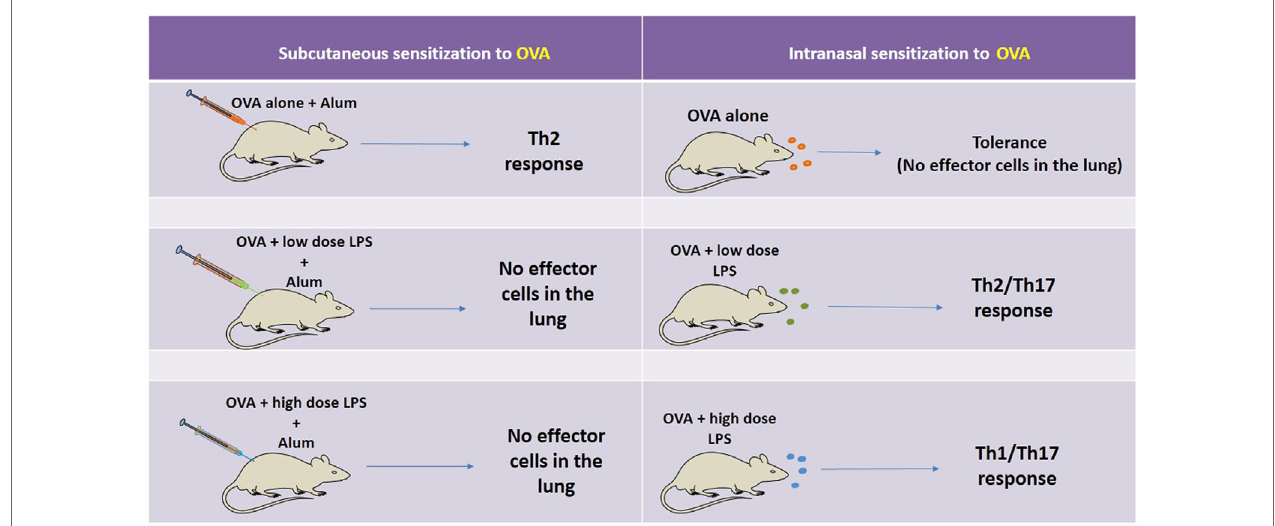
FiGuRe 2 | Schematic representation of the factors affecting OVA-model of allergic lung disease. On the left side, it is shown, that when sensitization is performed by the subcutaneous route with OVA adsorbed to Alum and the animals are challenged with intranasal OVA, an eosinophilic airway inflammation mediated by Th2 cells is developed. However, when the same sensitization is induced in the presence of low or high dose of lipopolysaccharide (LPS) and the animals are challenged with OVA, the airway inflammation is not developed. A different scenario is seen with intranasal sensitization to OVA. In this situation, OVA administration results in airway tolerance (no inflammation) while intranasal sensitization with OVA plus low or high dose of LPS results, respectively, in Th2-mediated airway eosinophilia or Th1/Th17-mediated airway neutrophilia. Therefore, part of the controversial reports can be ascribed to the route of sensitization and dose of